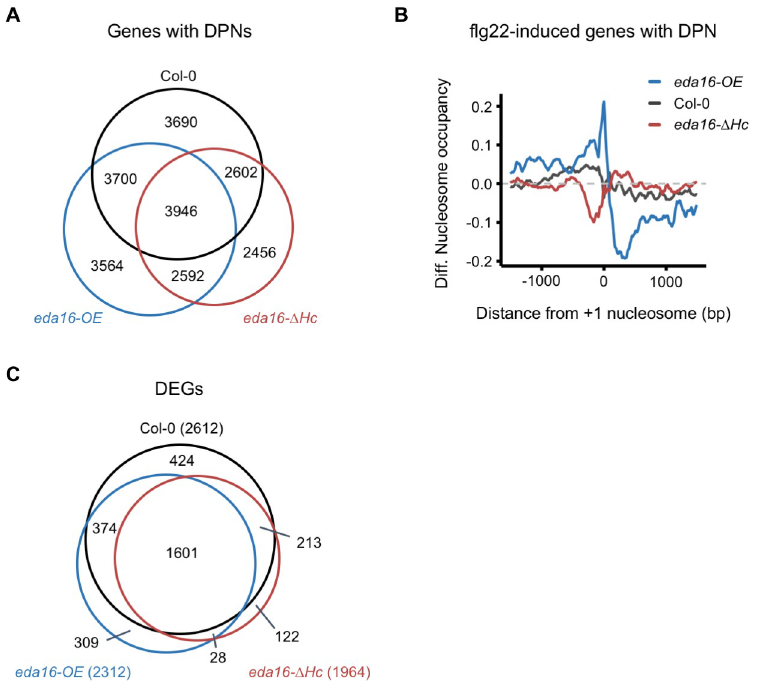
Fig 4. EDA16 alters nucleosome positioning and expression of flg22-regulated genes. (A) The EDA16 mutation alters flg22-induced nucleosome positioning. Venn diagram illustrating the overlap between genes (protein-coding genes plus 1000 nucleotides upstream their Transcription Start Sites, TSS) with at least one Differentially Positioned Nucleosome (DPN) in Col-0 (black), eda16-OE (blue) and eda16- Δ Hc (red) 2 hours after elicitation with 100 nM flg22. (B) flg22-induced genes have distinct nucleosome occupancies in the eda16-OE and eda16- Δ Hc mutants. Average of the nucleosome occupancy differences between flg22-treated and mock-treated Col-0 (black), eda16-OE (blue), and eda16- Δ Hc (red) for flg22-induced genes. The graph is centred on the +1 nucleosome from the gene TSS. (C) The effect of EDA16 mutation on the flg22 response at the transcriptomic level. Venn diagram illustrating the overlap between flg22-regulated, Differentially Expressed Genes (DEGs) in Col-0 (black), eda16-OE (blue) and eda16- Δ Hc (red) 2h after elicitation with 100 nM flg22.